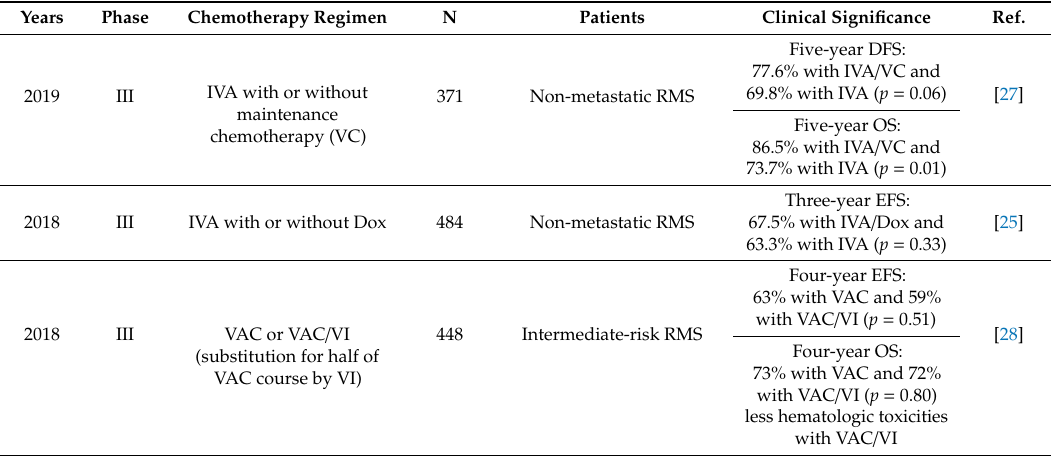
Table 1. Recent clinical trials on chemotherapy in patients with Rhabdomyosarcoma